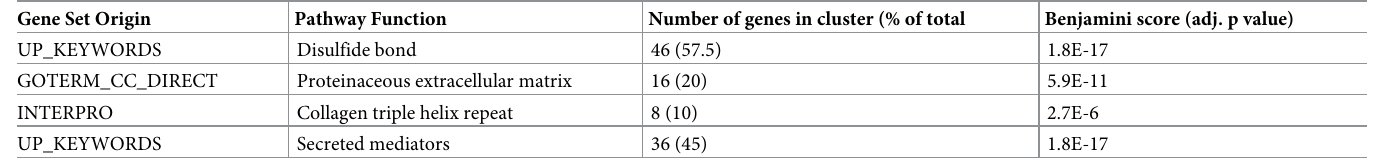
Table 2. Gene pathways enriched in IFN γ -R-/- livers. Gene Set